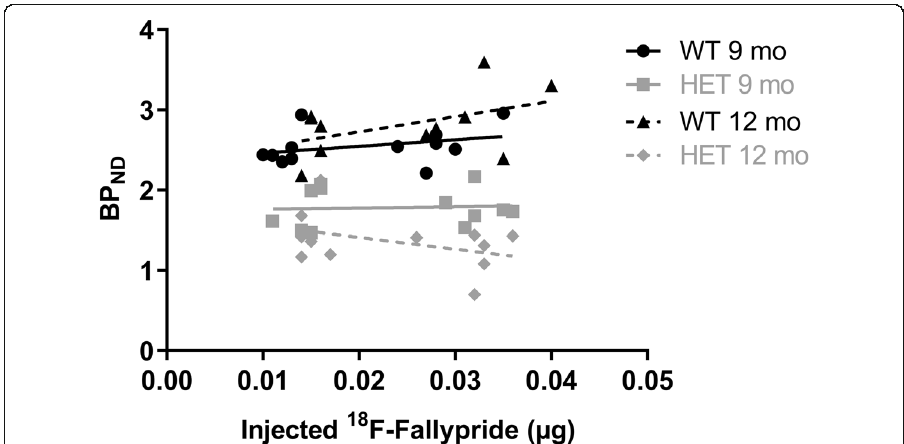
GBq/ μ mol) at the time of injection. Line represents linear regression of the population